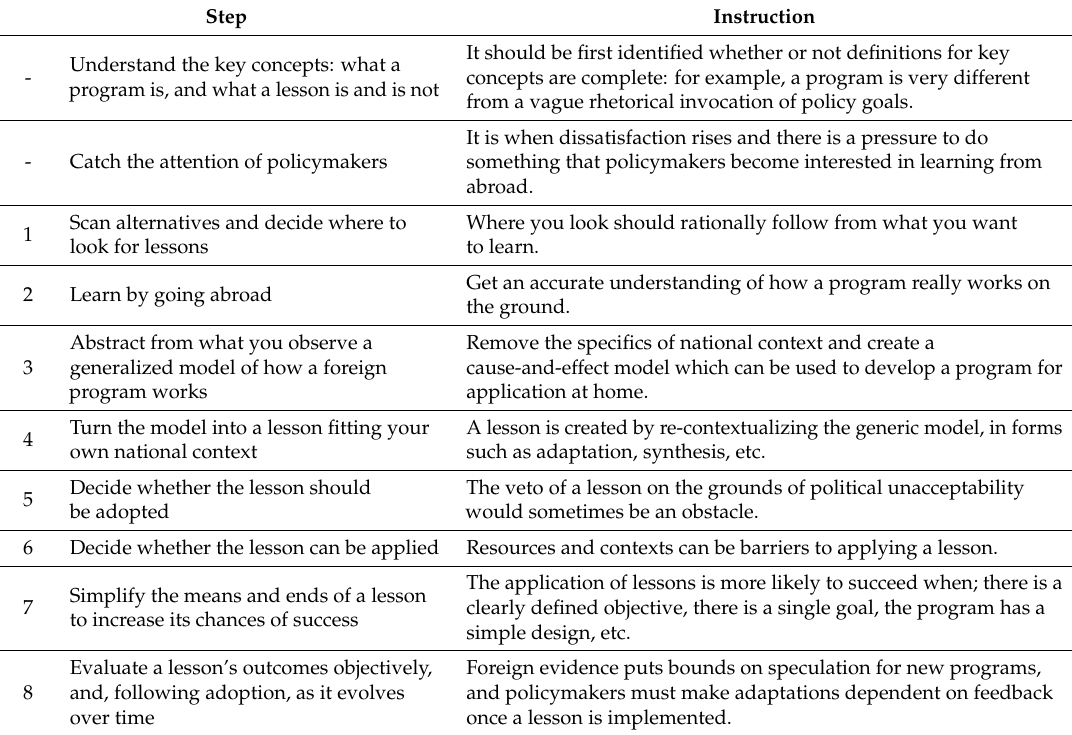
Table 2. Lesson-drawing Model for Policy Transfer Assessment (Rose